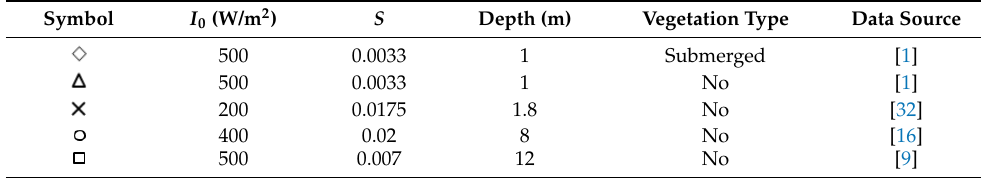
Table 1. Relevant parameters for field Table 1. Relevant parameters for field measurements. Table 1. Relevant parameters for field measurements. Table 1. Relevant parameters for field measurements. Table 1. Relevant parameters for field measurements. Table 1. Relevant parameters for field measurements.